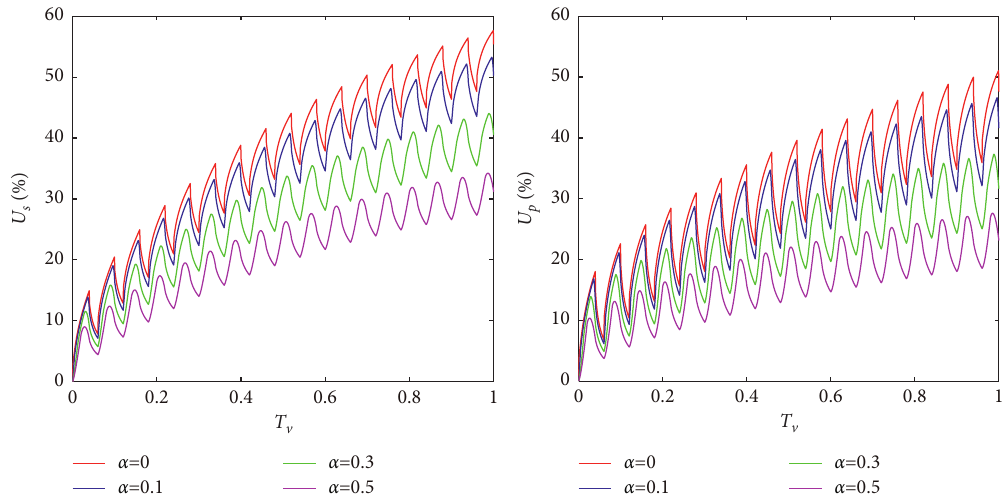
Figure 13: The variations of average degrees of consolidation U